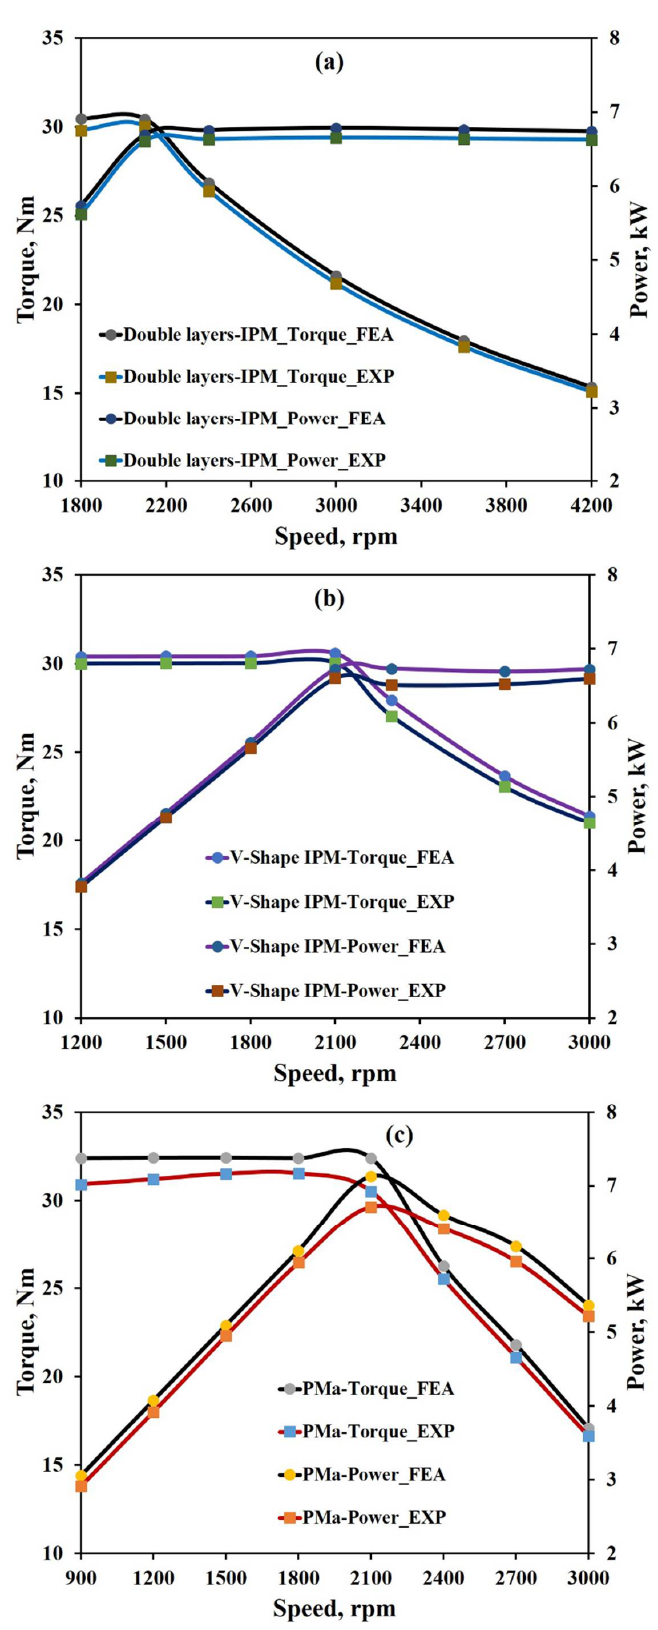
Figure 23. Torque-power vs speed curve at rated condition: ( a ) double layers IPMSM, ( b ) V-Shaped IPMSM, and ( c ) PMa-SynRM.